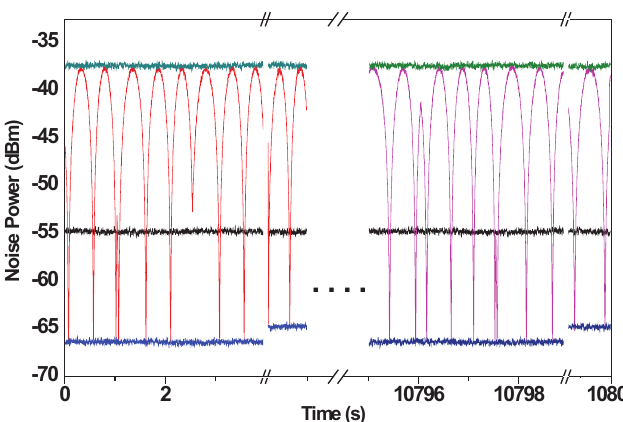
Figure 6. Long-term stability of the squeezed vacuum states of light recorded continuously for 3 h, with an RBW of 300 kHz, a VBW of 200 Hz, and a gate time of 3